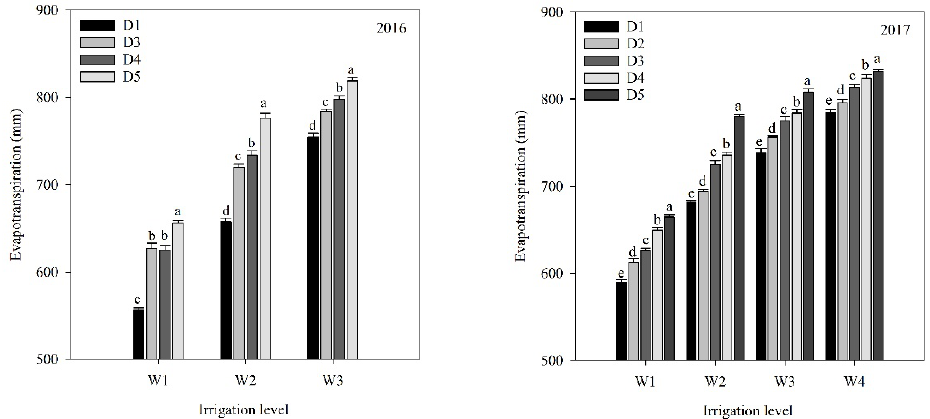
Figure 2. Changes of evapotranspiration under different irrigation levels and planting densities during the 2016 and 2017 maize growing seasons. W1, W2, W3, and W4 represent irrigation levels of 360, 480, 600, and 720 mm, respectively. D1, D2, D3, D4, and D5 represent planting densities of 7.5, 9.0, 10.5, 12.0, and 13.5 plants m − 2 , respectively. Means within a column and for the same site followed by different letters are significantly different at p < 0.05.